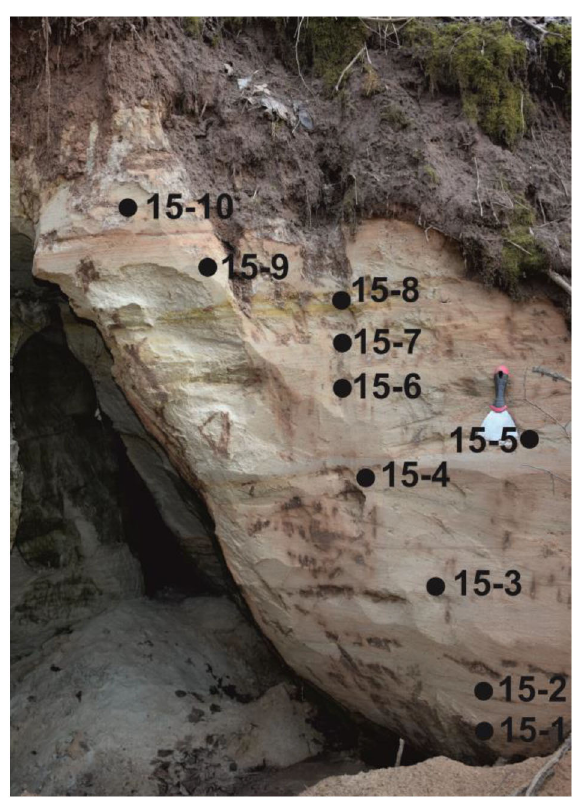
Fig. 2. Karksi outcrop. Levels of